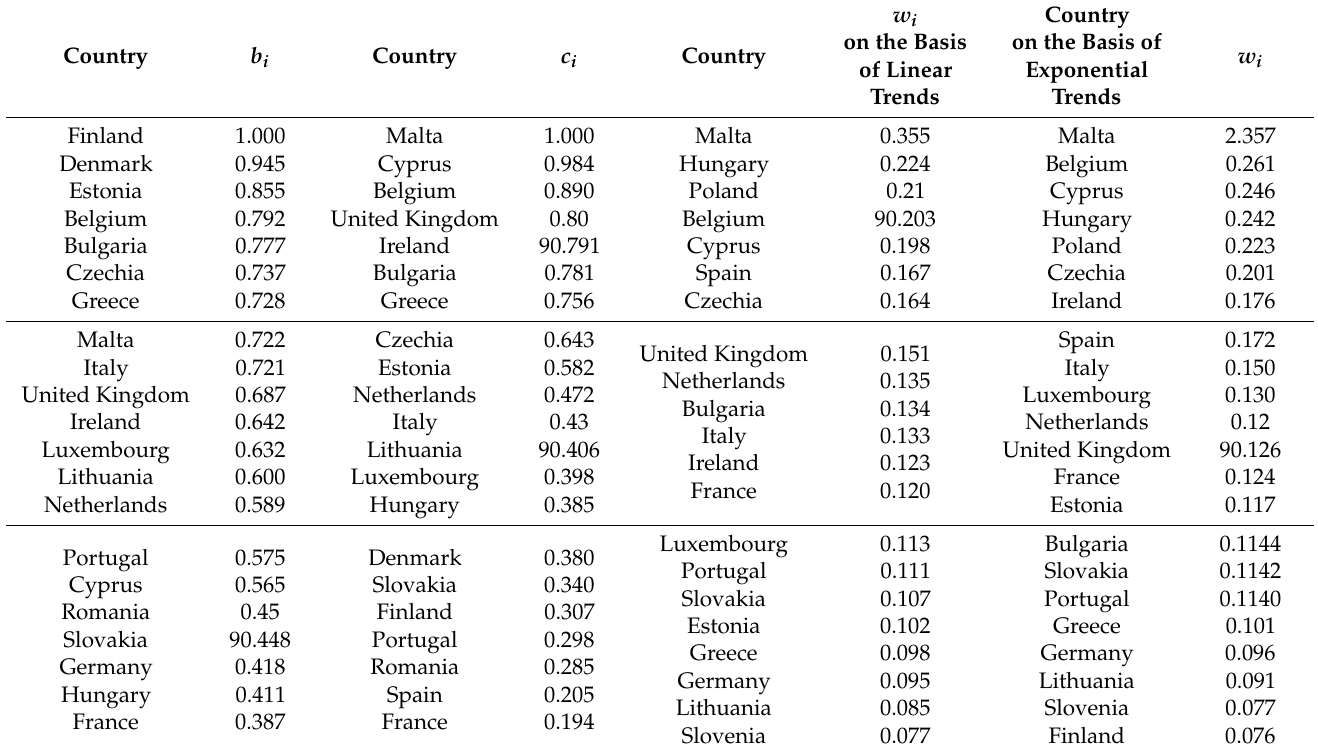
Table 3. Position in the rank of EU countries for using renewable energy sources in 2004–2019. Country b i Country c i Country